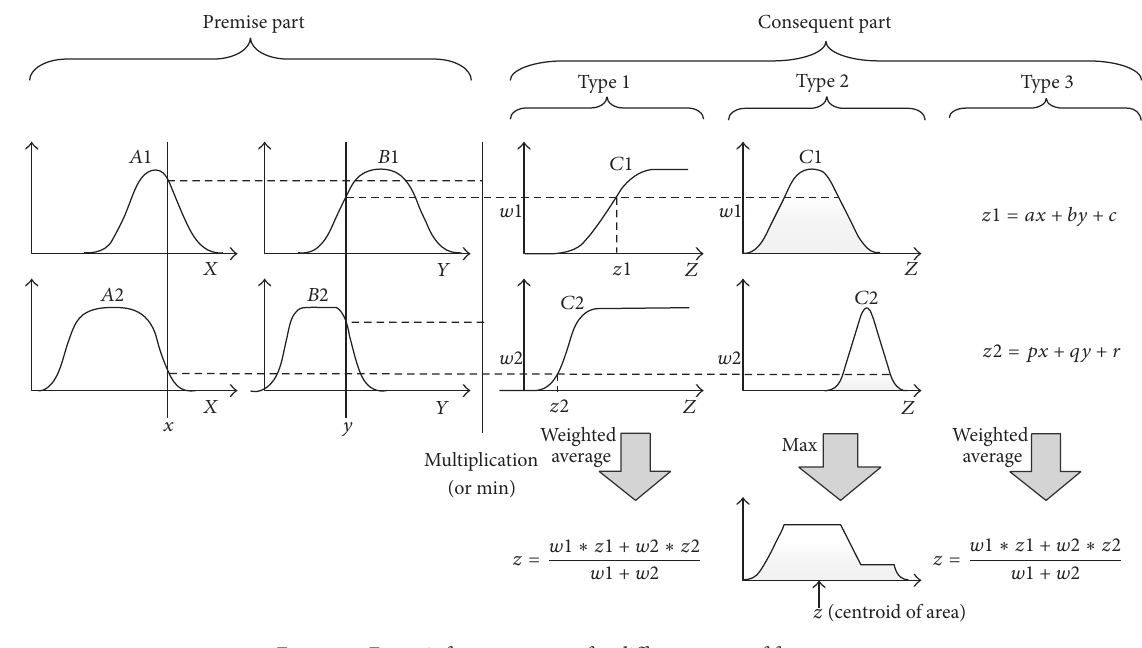
Figure 7: Fuzzy inference process for different types of fuzzy system.